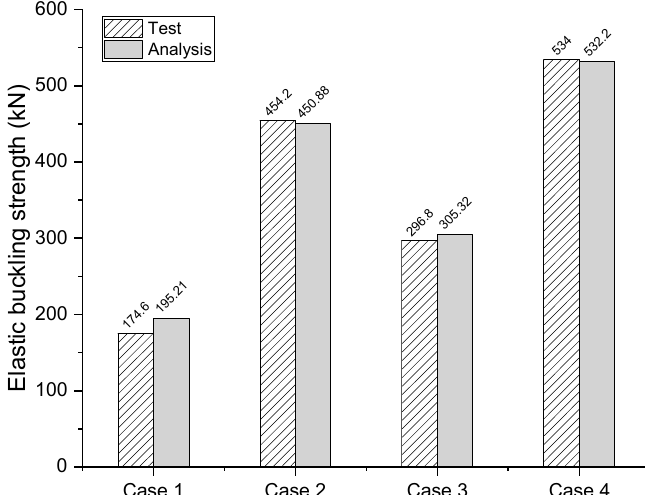
Figure 19. Nonlinear inelastic structural analysis and experimental results.